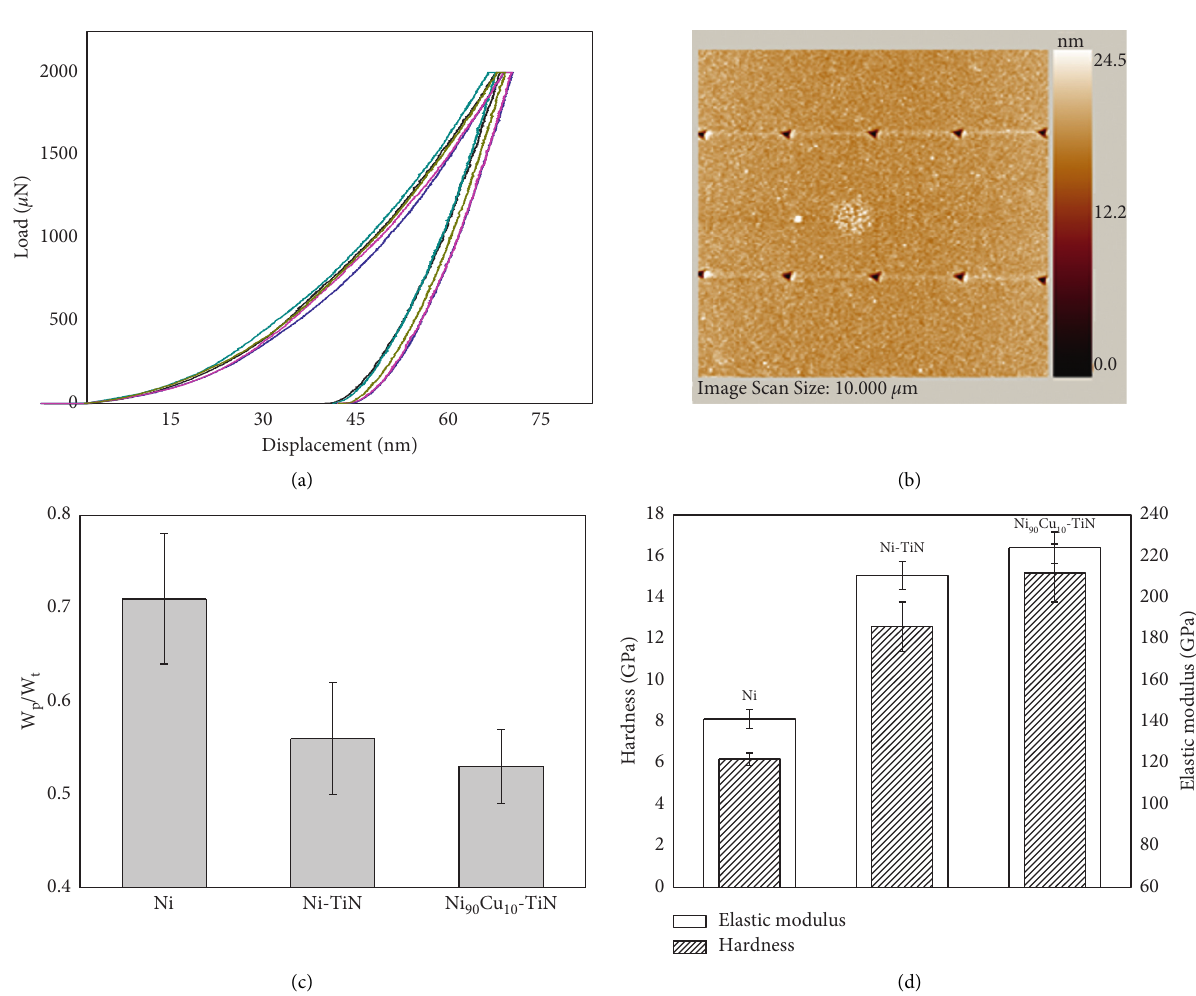
Figure 4: (a, b) Load—indentation curve and indentation image of Ni of Ni, Ni-TiN, and Ni 90 Cu 10 -TiN thin films.